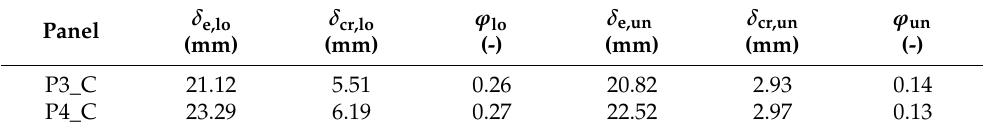
Table 9. Main results from the flexural creep tests.